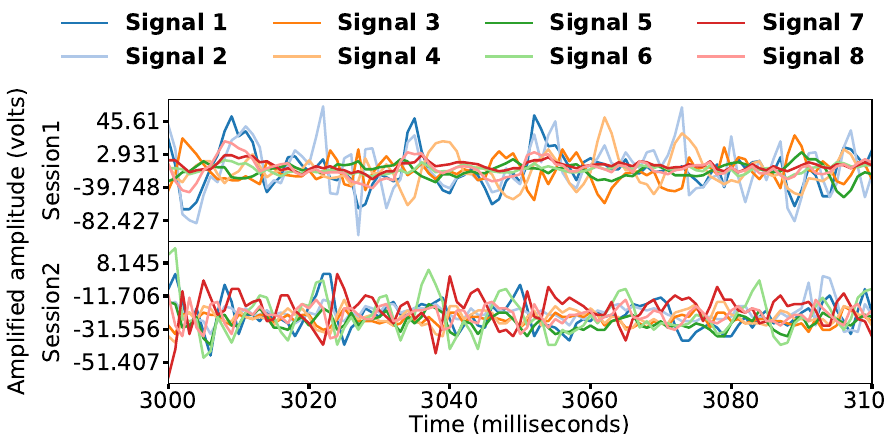
Figure 2. Samples of Participant 4’s acquired sEMG signals.